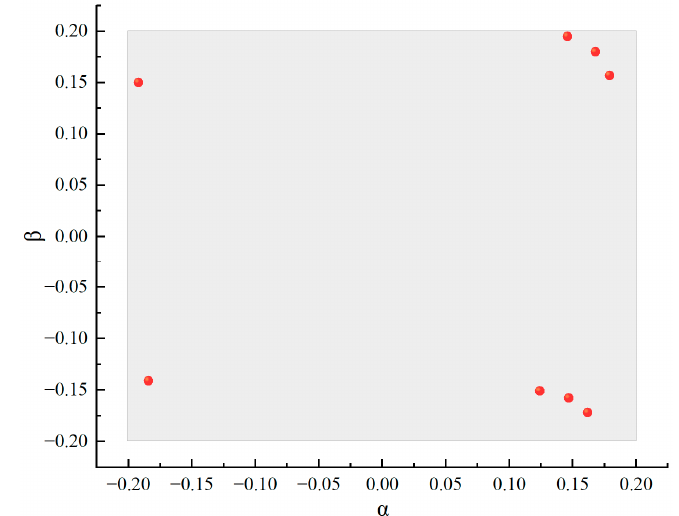
Figure 12. Performance indicators of test results. Table 2. Results of the levelling test.